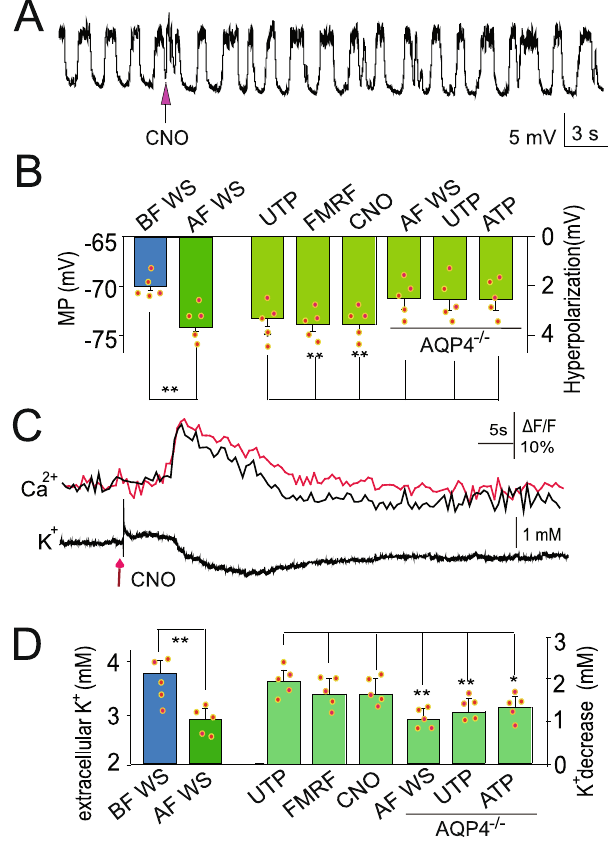
Fig. 6 | Astrocytic Ca 2+ transients enable glymphatic clearance of K + . A Typical whole-cell recordings show that membrane potentials hyperpolarize after CNO- inducedastrocyticCa 2+ transients. B Statisticalanalysisofwhiskerstimulation(WS) and agonist (UTP, FMRF, and CNO)-induced astrocytic Ca 2+ transient-induced membrane hyperpolarization (** P <0.01, the comparisonbetween the leftpair was done with paired t-test, n =5; the comparison was done with one-way ANOVA among the other groups, F(5,29) = 9.407, P <0.001; the spots show the value in each mouse, n =5 in each group; the data are shown as the mean±SD). C Typical traces show astrocytic Ca 2+ transients and extracellular K + . D Statistical analysis of extracellular K + changes due to whisker stimulation (WS) and agonist (UTP, FMRF, and CNO)-induced astrocytic Ca 2+ transients (** P <0.01, the comparison between the left pair was done with paired t-test, n =5; the comparison was done with one- wayANOVAamong the othergroups, F(5,29)= 13.87, P <0.001;the spots showthe value in each mouse, n =5 in each group, the data are shown as the